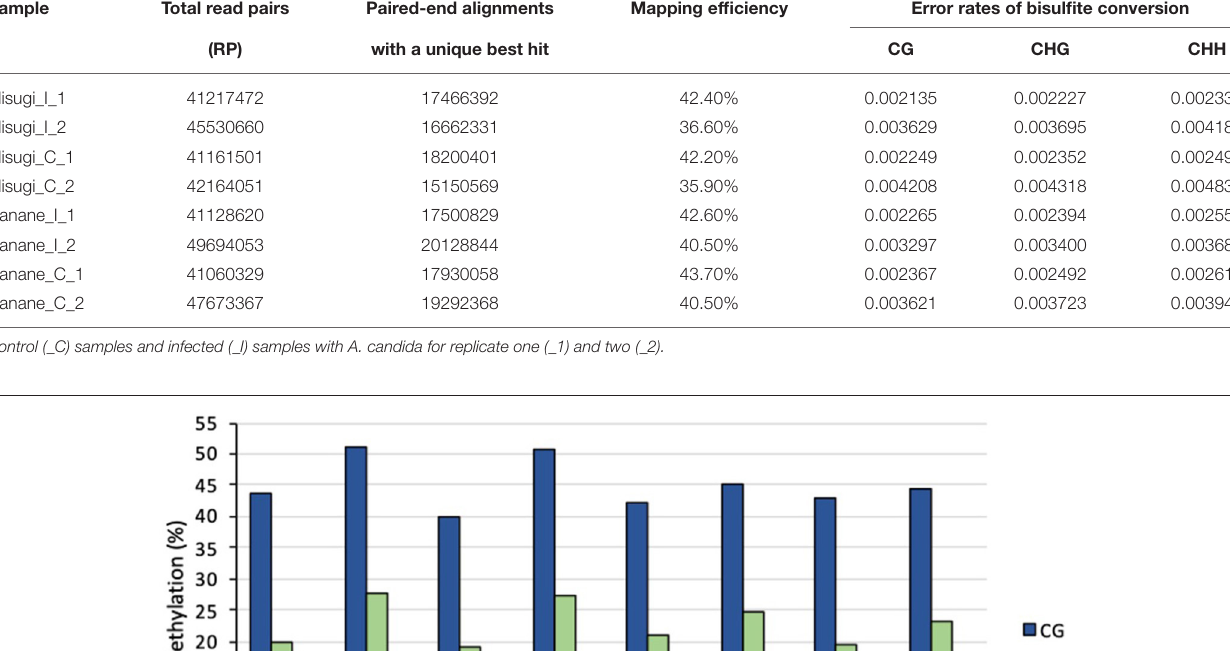
TABLE 1 | Mapping results and bisulfite conversion error of B. rapa cultivars “Misugi” (susceptible) and “Nanane” (resistant).